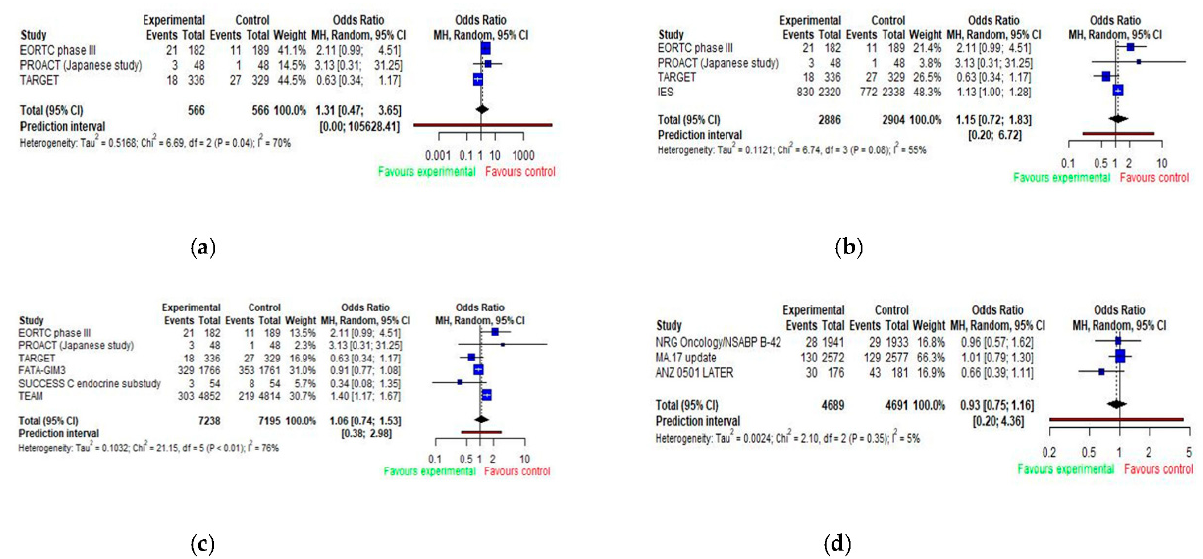
Figure 4. Forest plot of odds ratios for arterial hypertension with AIs by trial design ( a – d ). E (experimental group); C (control group). ( a ) E: AIs vs. C: tamoxifen (monotherapy); ( b ) E: AIs (monotherapy) or AIs + tamoxifen (sequence) vs. C: tamoxifen (monotherapy); ( c ) E: AIs (monotherapy) vs. C: AIs + tamoxifen (sequence) or tamoxifen (monotherapy); ( d ) E: AIs (monotherapy) vs. C: placebo/no treatment.